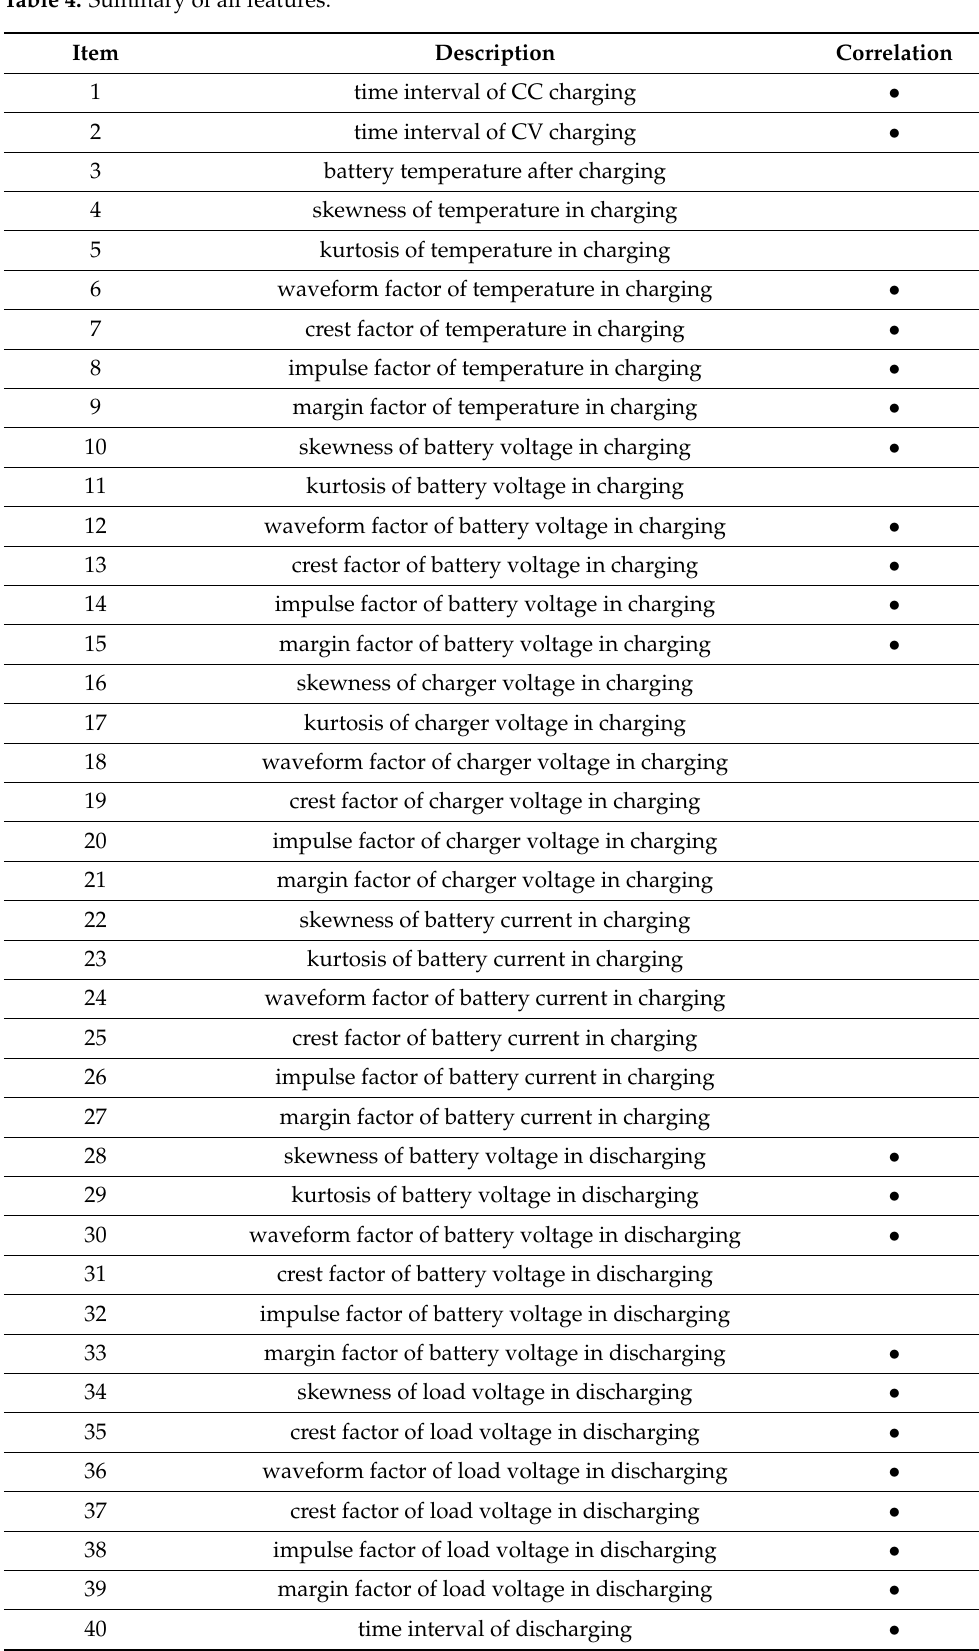
Table 4. Summary of all